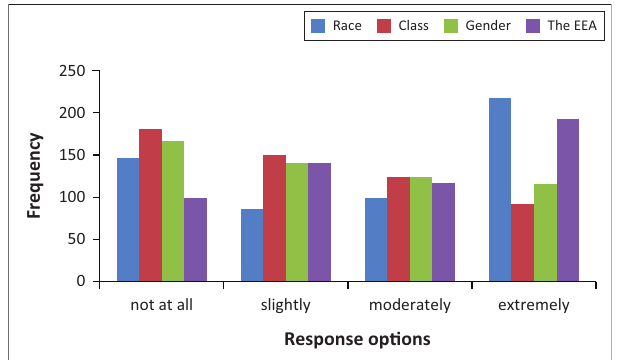
FIG URE 2: Reflect increased concerns in promotional opportunities. TABLE 4: Summary of results pertaining to Question 2. Question 2: Do you experience that, when promotional opportunities become available, there are increased concerns about whether … will play a role in the